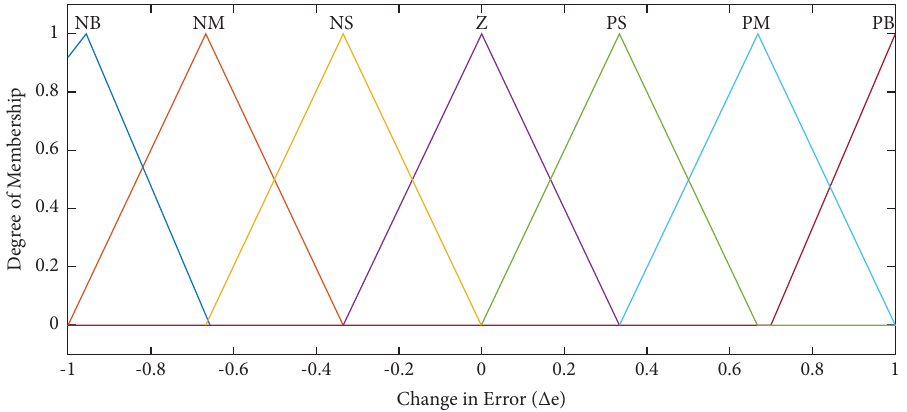
Figure 11: Input (change-in-error) for dq -axis.